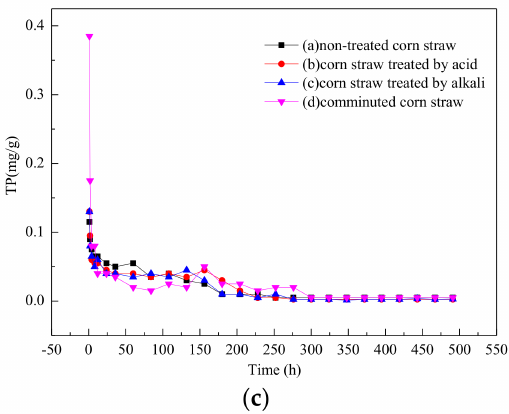
Figure 2. COD, TN, TP dissolution trends of corn straw pretreated with different methods; ( a ) COD; ( b ) TN; and ( c ) TP.